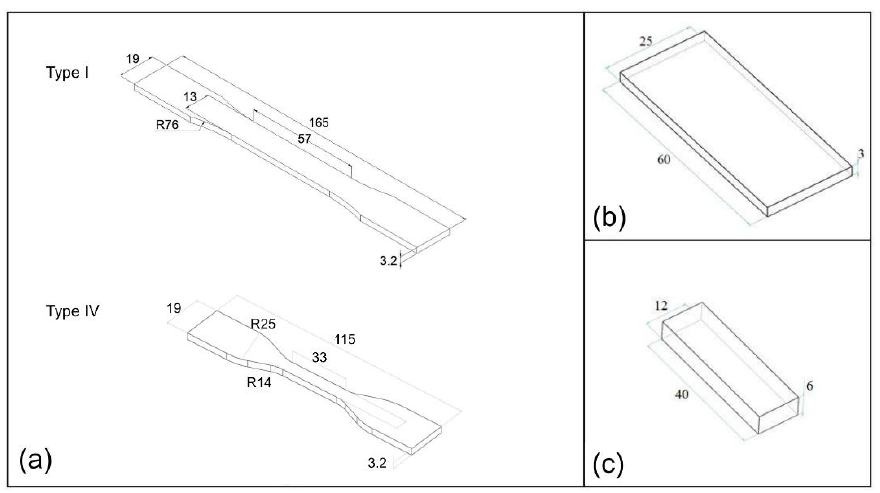
Figure 1. Dimensions (in mm) of the specimens. ( a ) Tensile test specimens (ASTM D638 type I, IV); ( b ) flexural test specimens; ( c ) short-beam shear specimens.